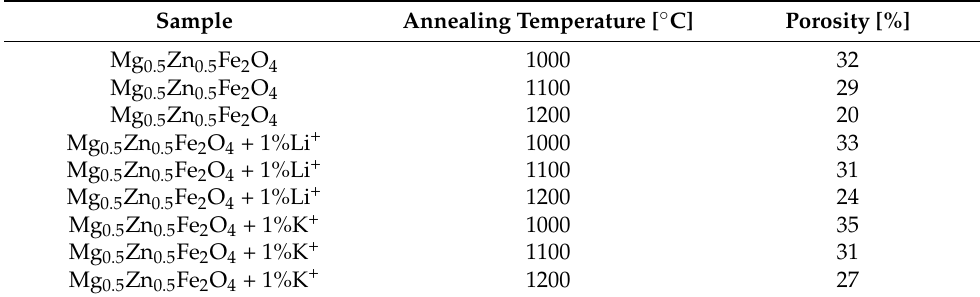
Table 1. The porosity of Mg-Zn ferrites.